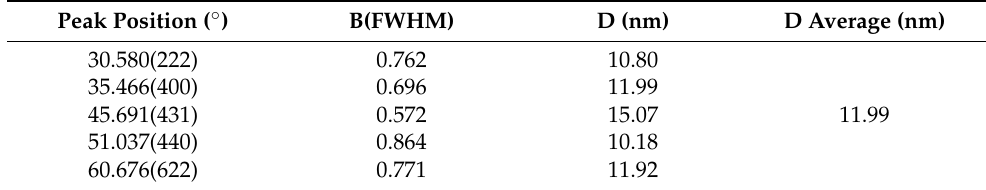
Table 5. Grain size of different planes of ITO NPs.